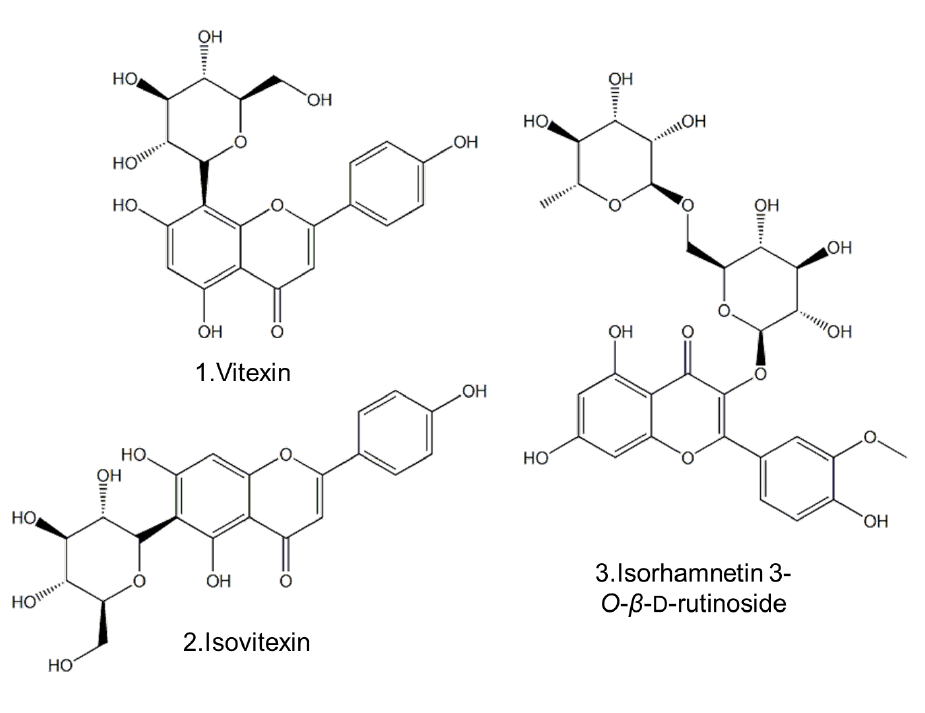
Figure 1. Chemical structures of the three flavonoid glycosides 1 – 3